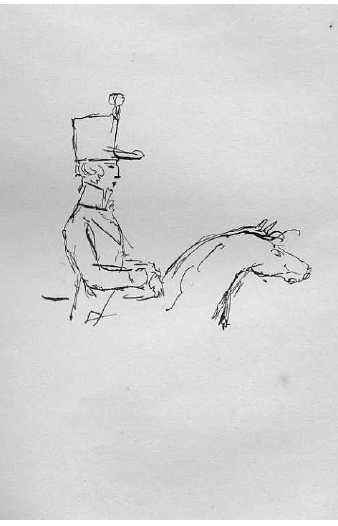
Figure 32. Konstantin Batiushkov. A self-portrait in a letter to Nikolai Gnedich from Narva, 2 March 1807. Lost.